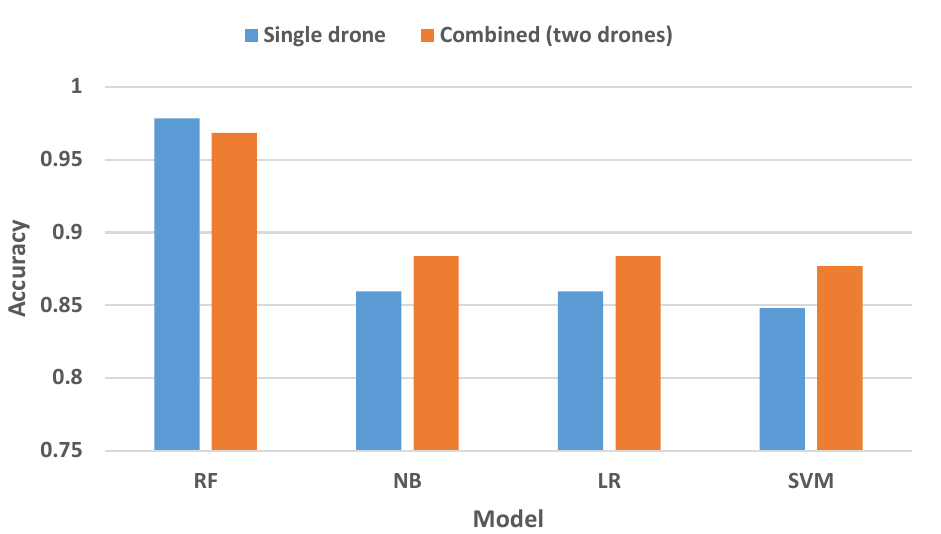
Figure 13. Comparison of model accuracy for datasets obtained from (blue) single and (orange) combined (two